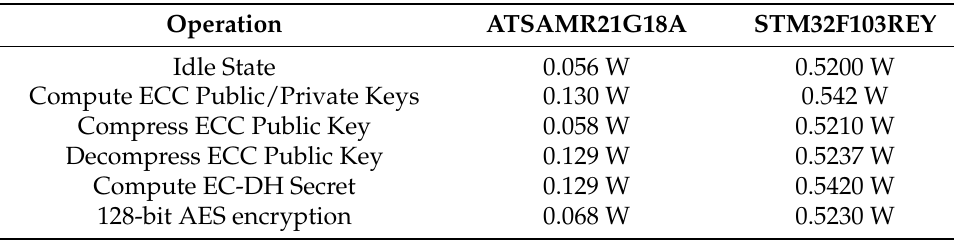
Table 9. Power consumption of each ECC operations, the encryption of a single 128-bits AES block and during the idle state (in